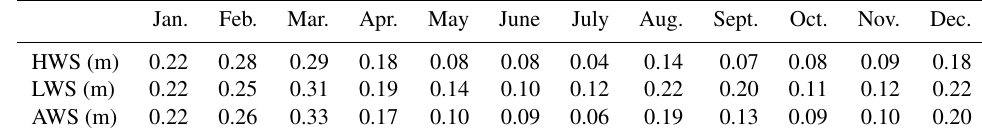
Table 3. The highest, lowest and average variation of Taihu water stage before 2001 and after 2002.